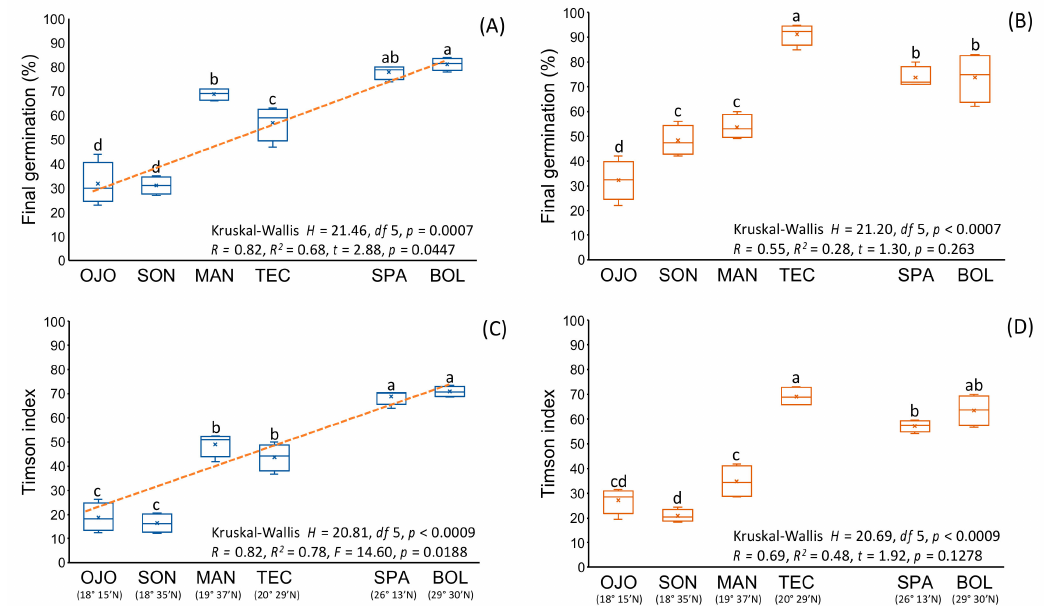
Figure 3. Final germination and Timson index of the seeds obtained by self- ( A , C ) and cross- ( B , D ) pollination in native populations of Oenothera drummondii . Comparison among populations (Kruskal–Wallis nonparametric ANOVA) and the relationship between the reproductive characteristic and latitude (linear regression analysis) are shown in each graph. Population acronyms are explained in Table A1. Latitudinal ubication is indicated below each acronymous. Dotted lines representing significant regression analyses but are not in scale with the latitudinal increase. Different letters above the boxes indicate significant differences among populations (Steel–Dwass all pairs multiple comparisons p < 0.001). Boxes show the average (x), median (-) and